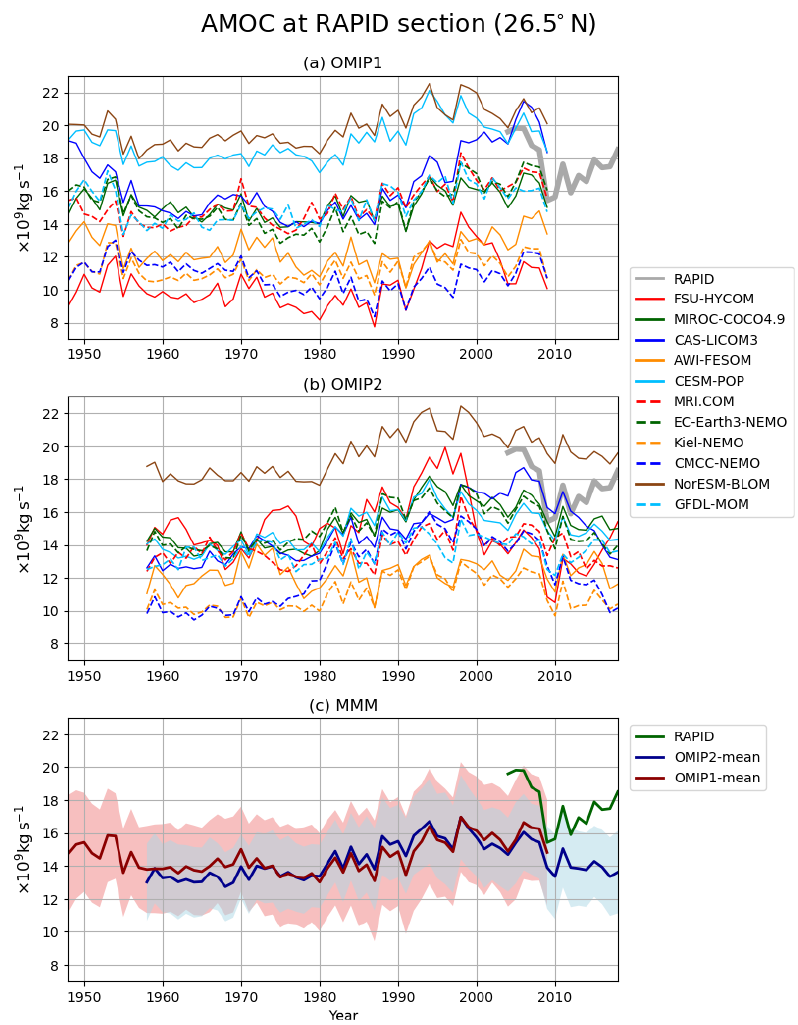
Figure 19. Time series of annual mean AMOC maximum at 26.5 ◦ N, which represents the strength of AMOC associated with North Atlantic Deep Water formation. (a) OMIP-1, (b) OMIP-2, (c) multi-model mean (lines) and spread defined as 1 standard deviation (shades) of OMIP-1 (red) and OMIP-2 (blue). The estimate based on the RAPID observation (e.g., Smeed et al., 2019) is depicted with the grey line in panels (a) and (b) and the green line in (c) . From Figs. 19 to 26, all participating models have been included in the multi-model ensemble mean. Units are 10 9 kgs − 1